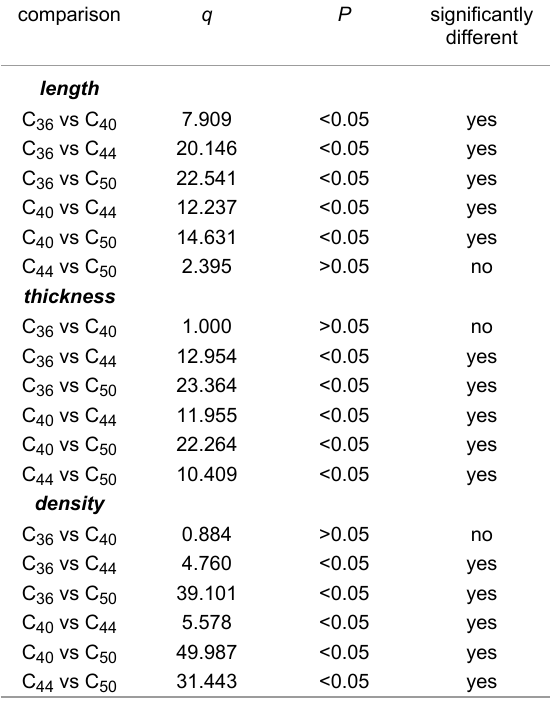
(Figure 3b): the lowest force was measured on C 36 (0.800 ± 0.712 mN) and the highest one on C 50 (3.092 ± 1.094 mN). However, significant differences in force values were found only in C 50 vs C 36 and C 50 vs C 40 (Table 4). In other pairs of surfaces, differences were non-significant (Table 4). Correlations between forces and different wax surface parame- ters (crystal length, crystal thickness, density of crystals, mean roughness , and root mean square of roughness) were